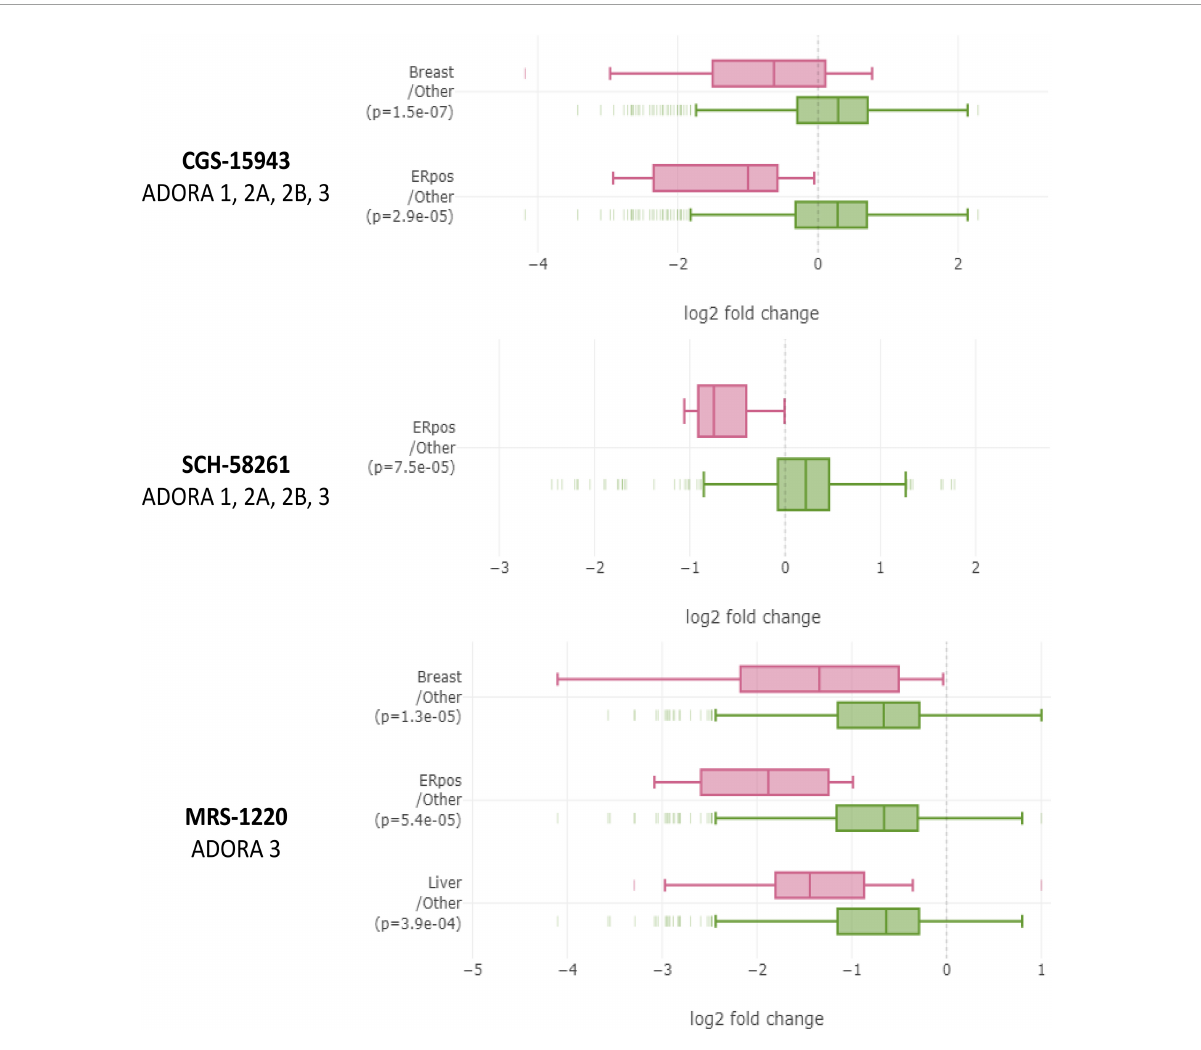
FIGURE7 Breast cancer cell lines, especially ER + ones, are uniquely sensitive to non-xanthine adenosine receptor antagonists in large-scale PRISM screen performed by The Drug Repurposing Hub. In the Drug Repurposing Hub, numerous different cell lines are barcoded, pooled, and relative barcode frequency is collected after drug treatment. Non-xanthine A3 antagonists CGS-15943, SCH-68261, and MRS-1220 each decreased relative quantities of ER + breast cancer cell lines relative to other cell lines. Data were analyzed on DepMap portal using the limma R statistical package. Significant differences were considered by p <